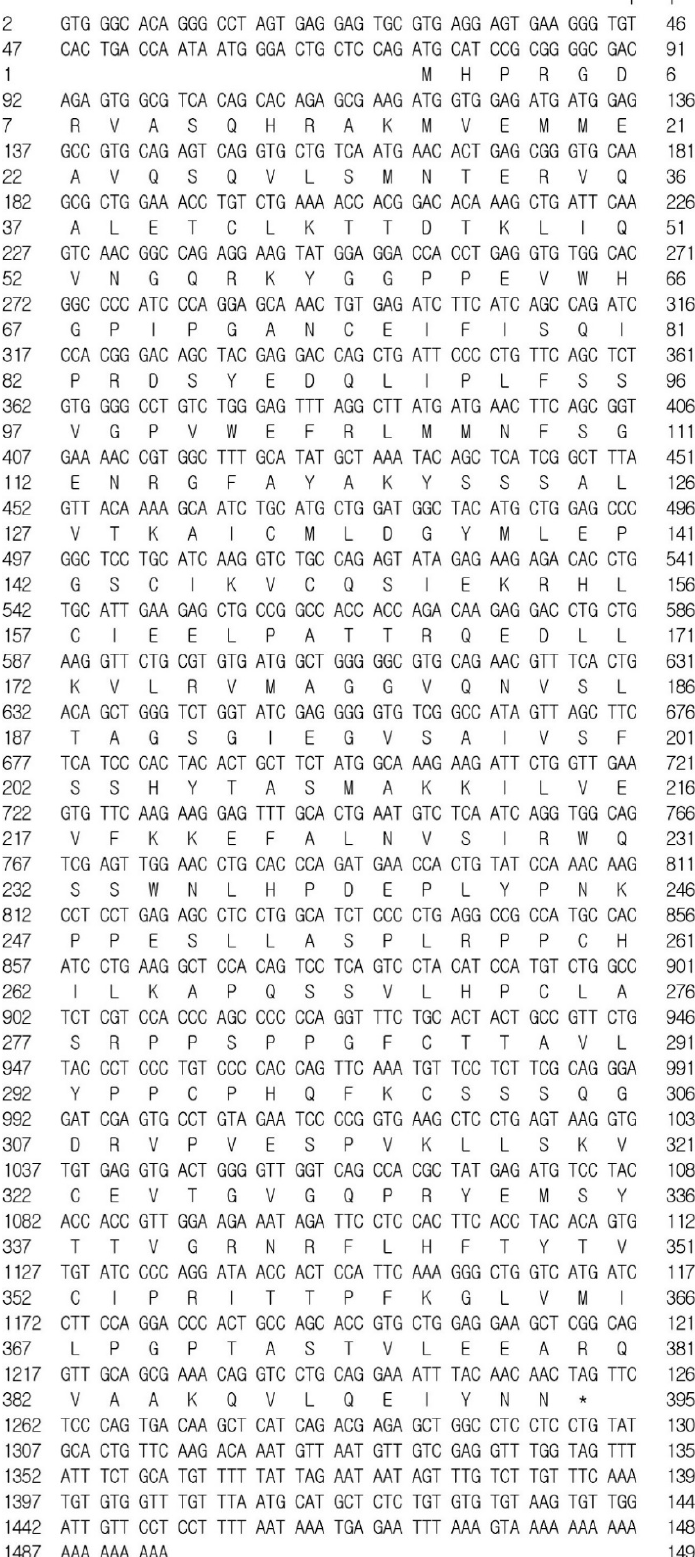
Figure 1. Nucleotide and amino acid sequence of psdnd. The first methionine amino acid indicates the start codon. Strock indicates the stop codon. Amino acid sequence was analyzed by clustal omega website available at https://www.ebi.ac.uk/Tools/msa/clustalo/ (accessed on 15 March 2020).